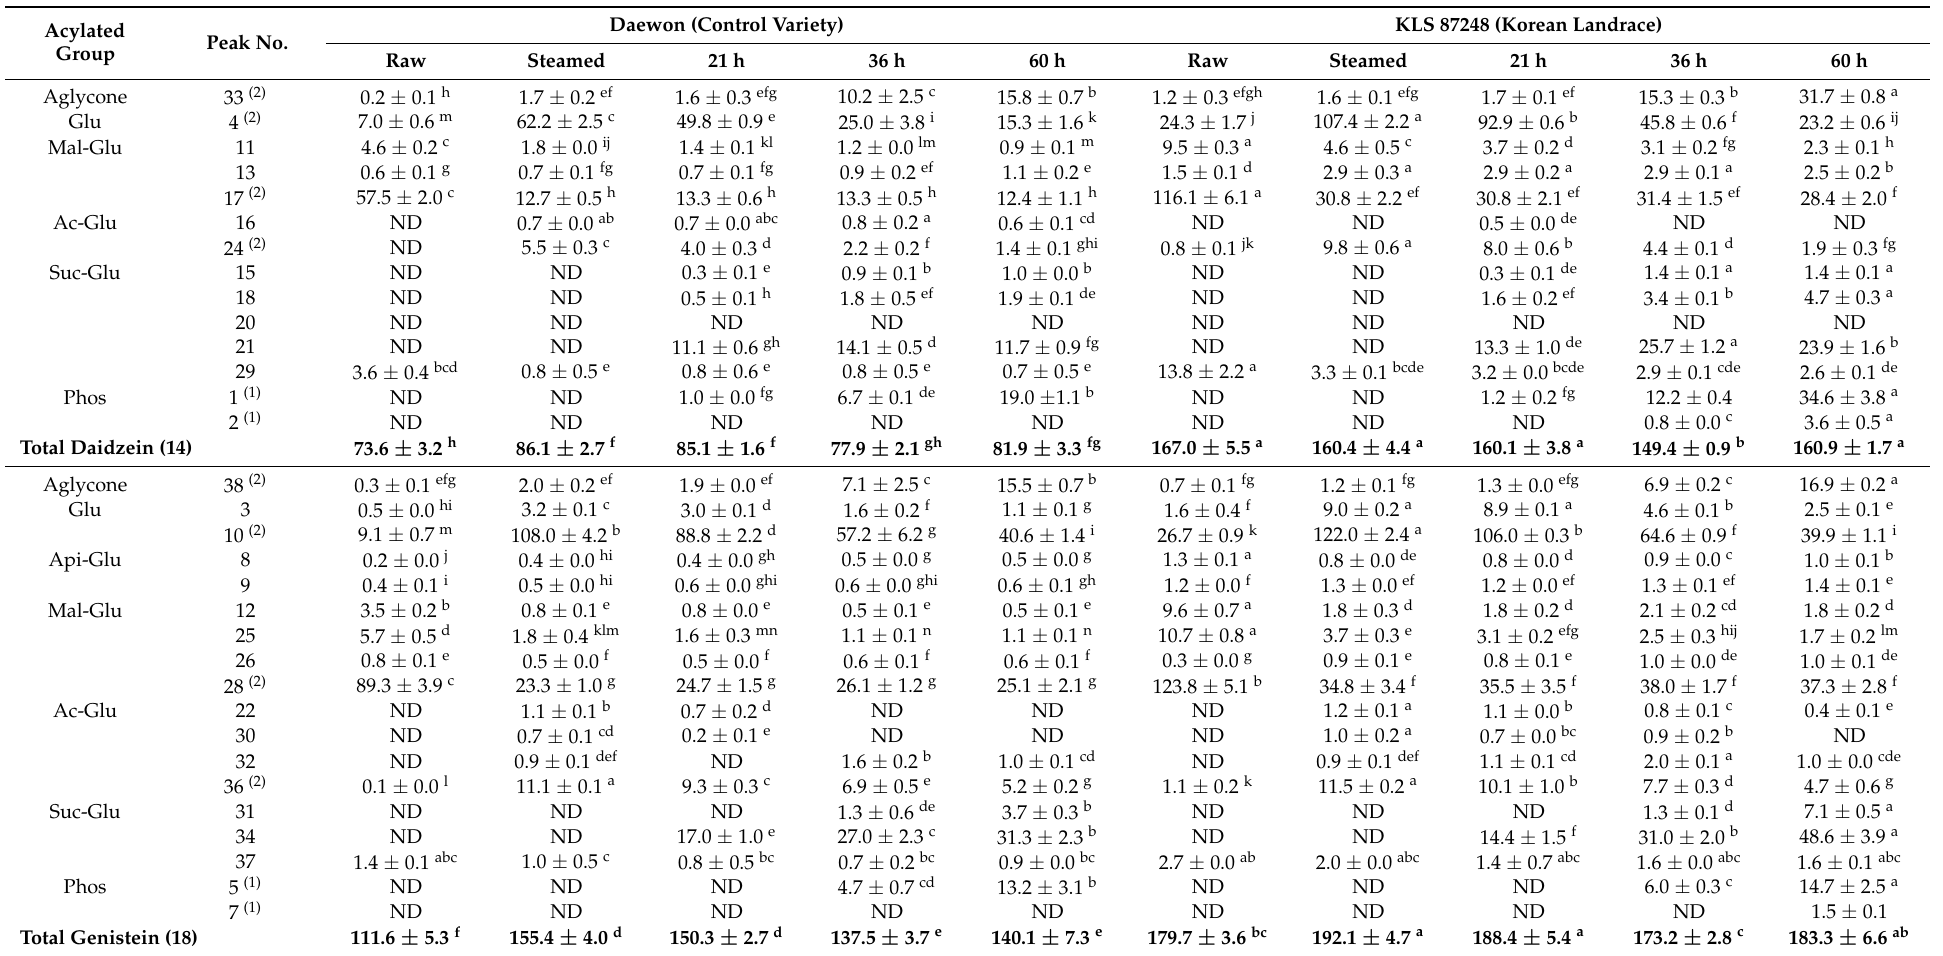
Table 2. Changes in content of thirty-eight isoflavone derivatives during steaming and fermentation (after 21, 36 and 60 h) from the four selected soybean cultivars. Acylated